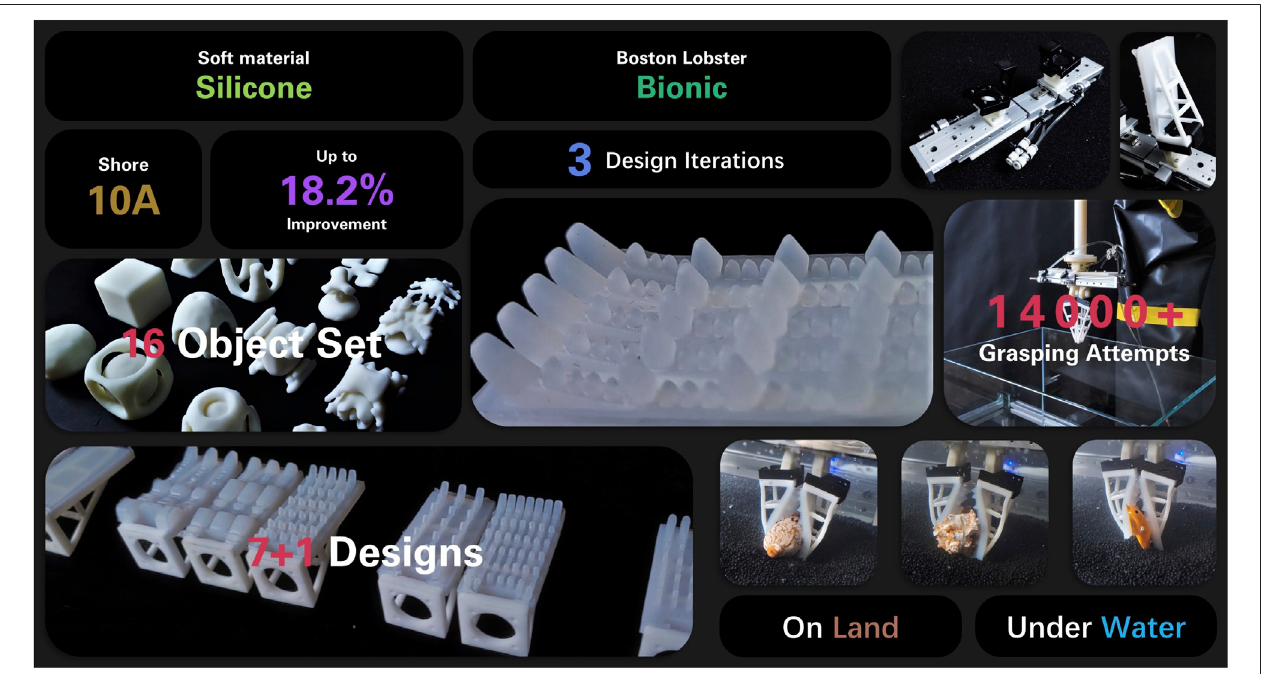
FIGURE 1 | Inspired by the Boston Lobster, we designed 7 bionic fi nger surface patterns in 3 iterations and fabricated them using silicone of Shore 10A. The designs are attached to the soft adaptive fi ngers and are tested on a set of 16 challenging objects. The optimal design is selected through over 14,000 grasp attempts, proves its capability and competence not only on land, but also underwater, and shows an improvement of up to 18.2%.